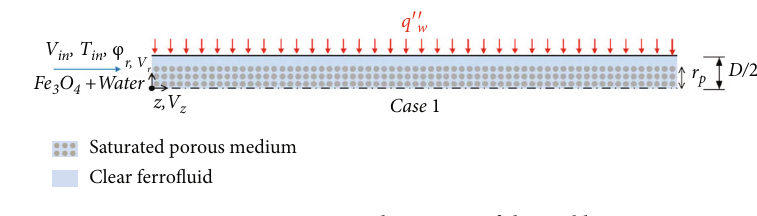
Figure 4: Geometrics description of the problem.